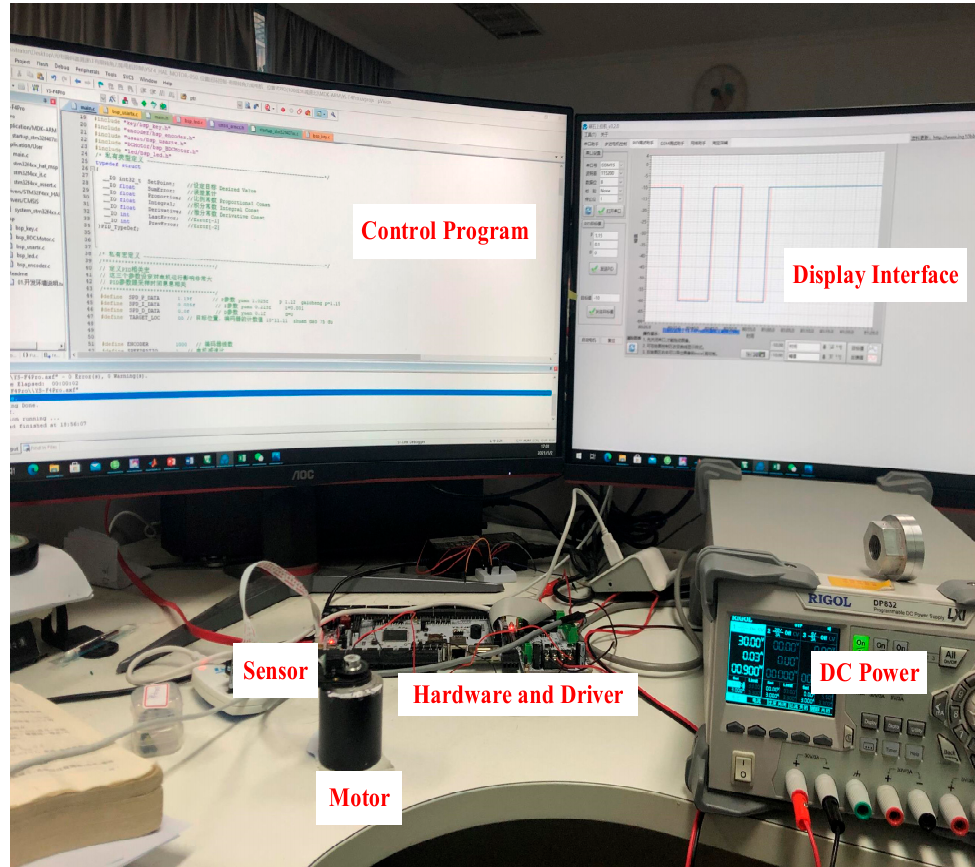
Figure 15. LATM control experiment environment.